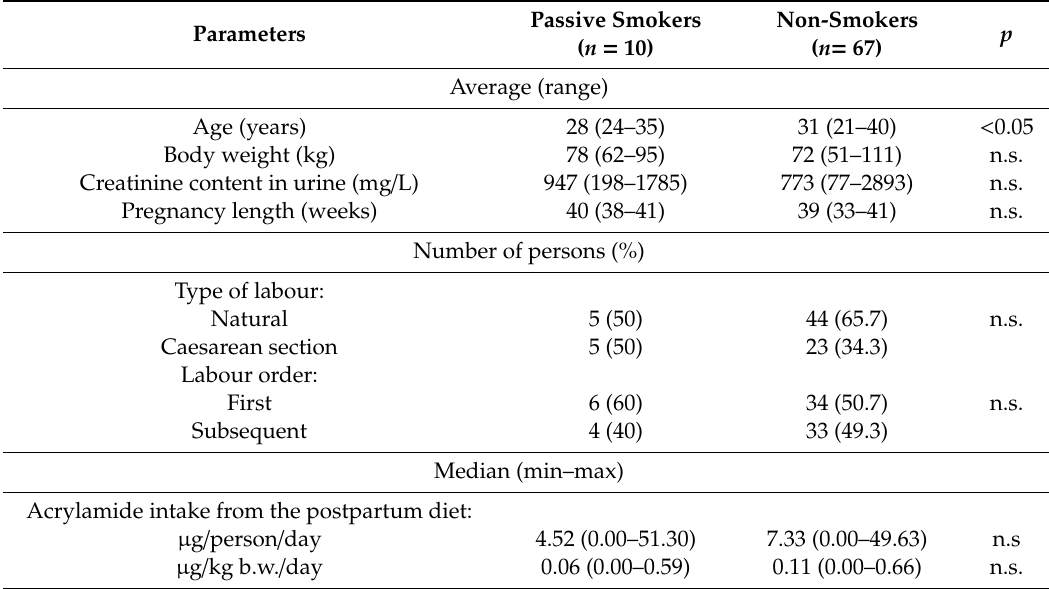
Table 1. Characteristics of